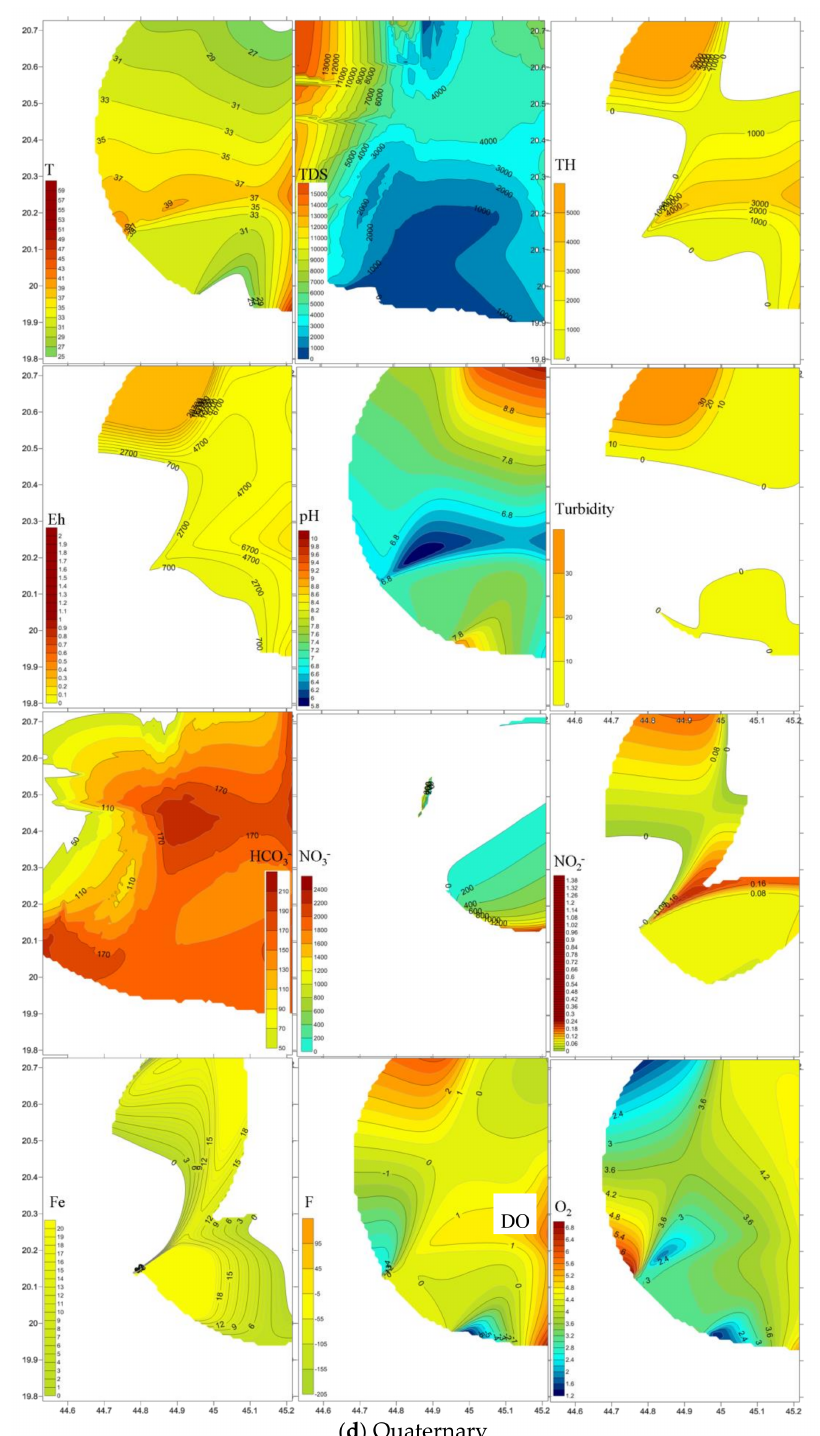
Figure 5. Spatial distribution of pollutants in the ( a ) Lower Wajid, ( b ) Upper Wajid, ( c ) Khu ff -Kumdah, and ( d ) Quaternary